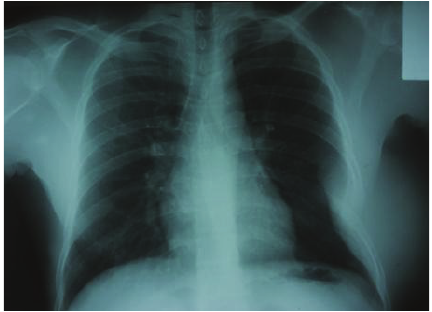
Figure 2: Chest X-ray showing unilateral peripheral opacity.